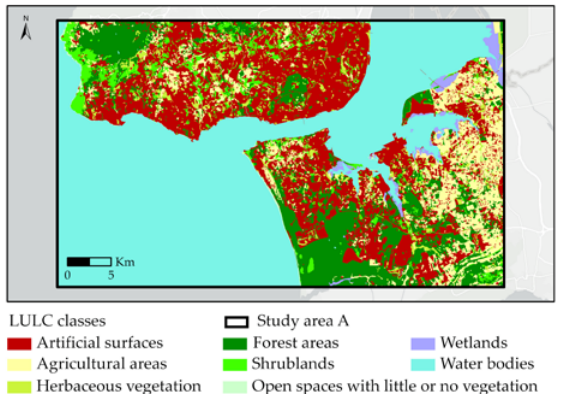
Figure 4. Map resulting from the conversion of COS 2018 to the classes used in the classification (shown in Table 4) for study area A.